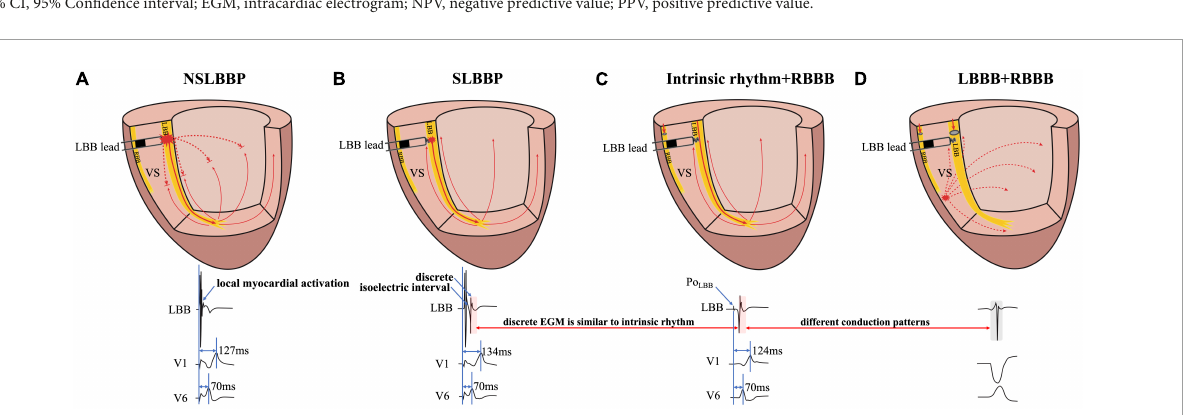
FIGURE1 Schematic diagram of different conduction patterns in a patient with RBBB and intermittent LBBB. (A) NSLBBP captures both the local myocardium and LBB without the presence of isoelectric interval and discrete local ventricular EGM. (B) In SLBBP, pacing electrical stimulation is conducted through the conduction system to the apex and propagates to the base of the interventricular septum. Isoelectric interval and discrete local ventricular EGM were observed. (C) Intrinsic conduction antegrade to the apex and propagates to the base. Morphology of intrinsic and paced ventricular EGMs was nearly identical (red rectangle). (D) The EGM morphology of LBBP is similar to the native rhythm but different from the EGM morphology of LBBB (red and gray rectangle). NSLBBP, non-selective left bundle branch pacing; SLBBP, selective left bundle branch pacing; EGM, intracardiac electrogram; LBB, left bundle branch; LBBB, left bundle branch block; RBBB, right bundle branch block; VS, ventricular